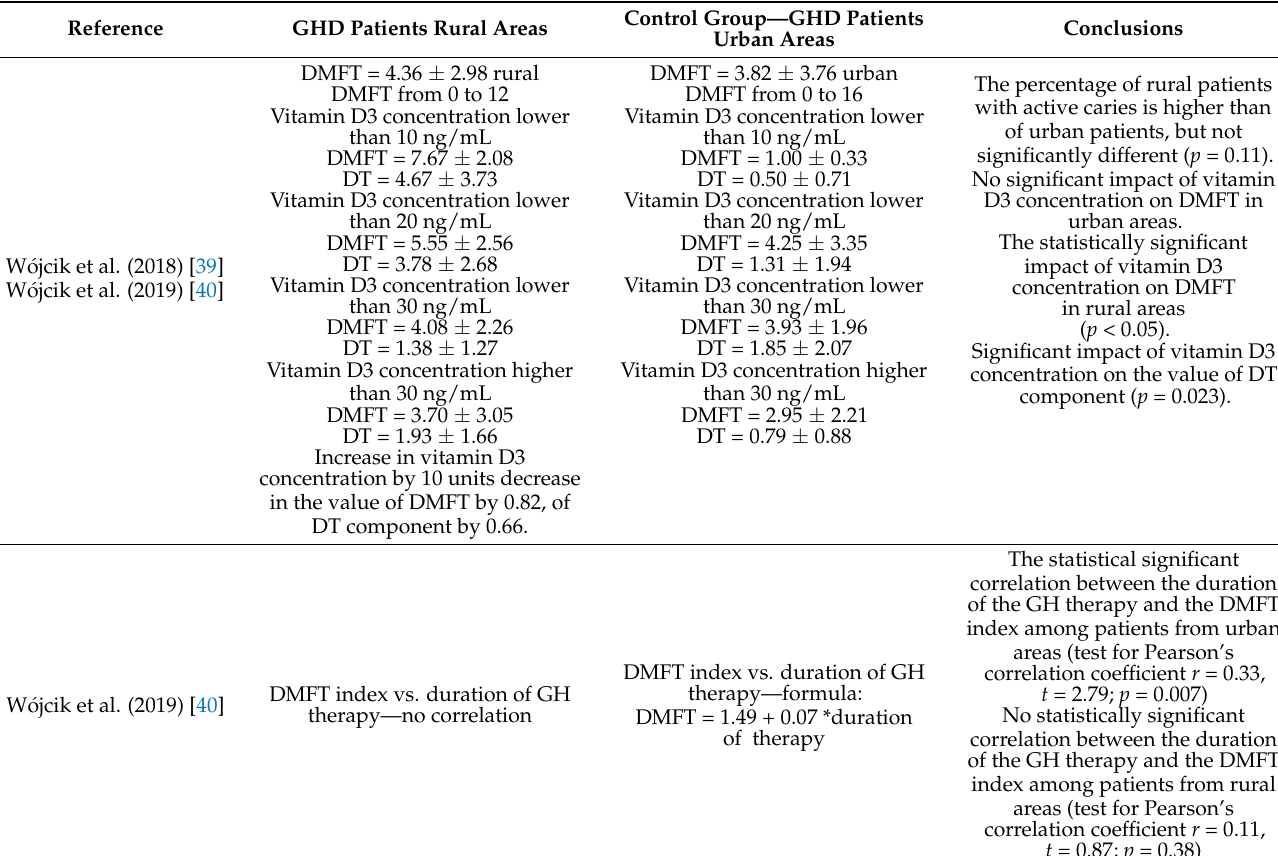
Table 2. Dental caries experience—data abstracted from studies included in systematic